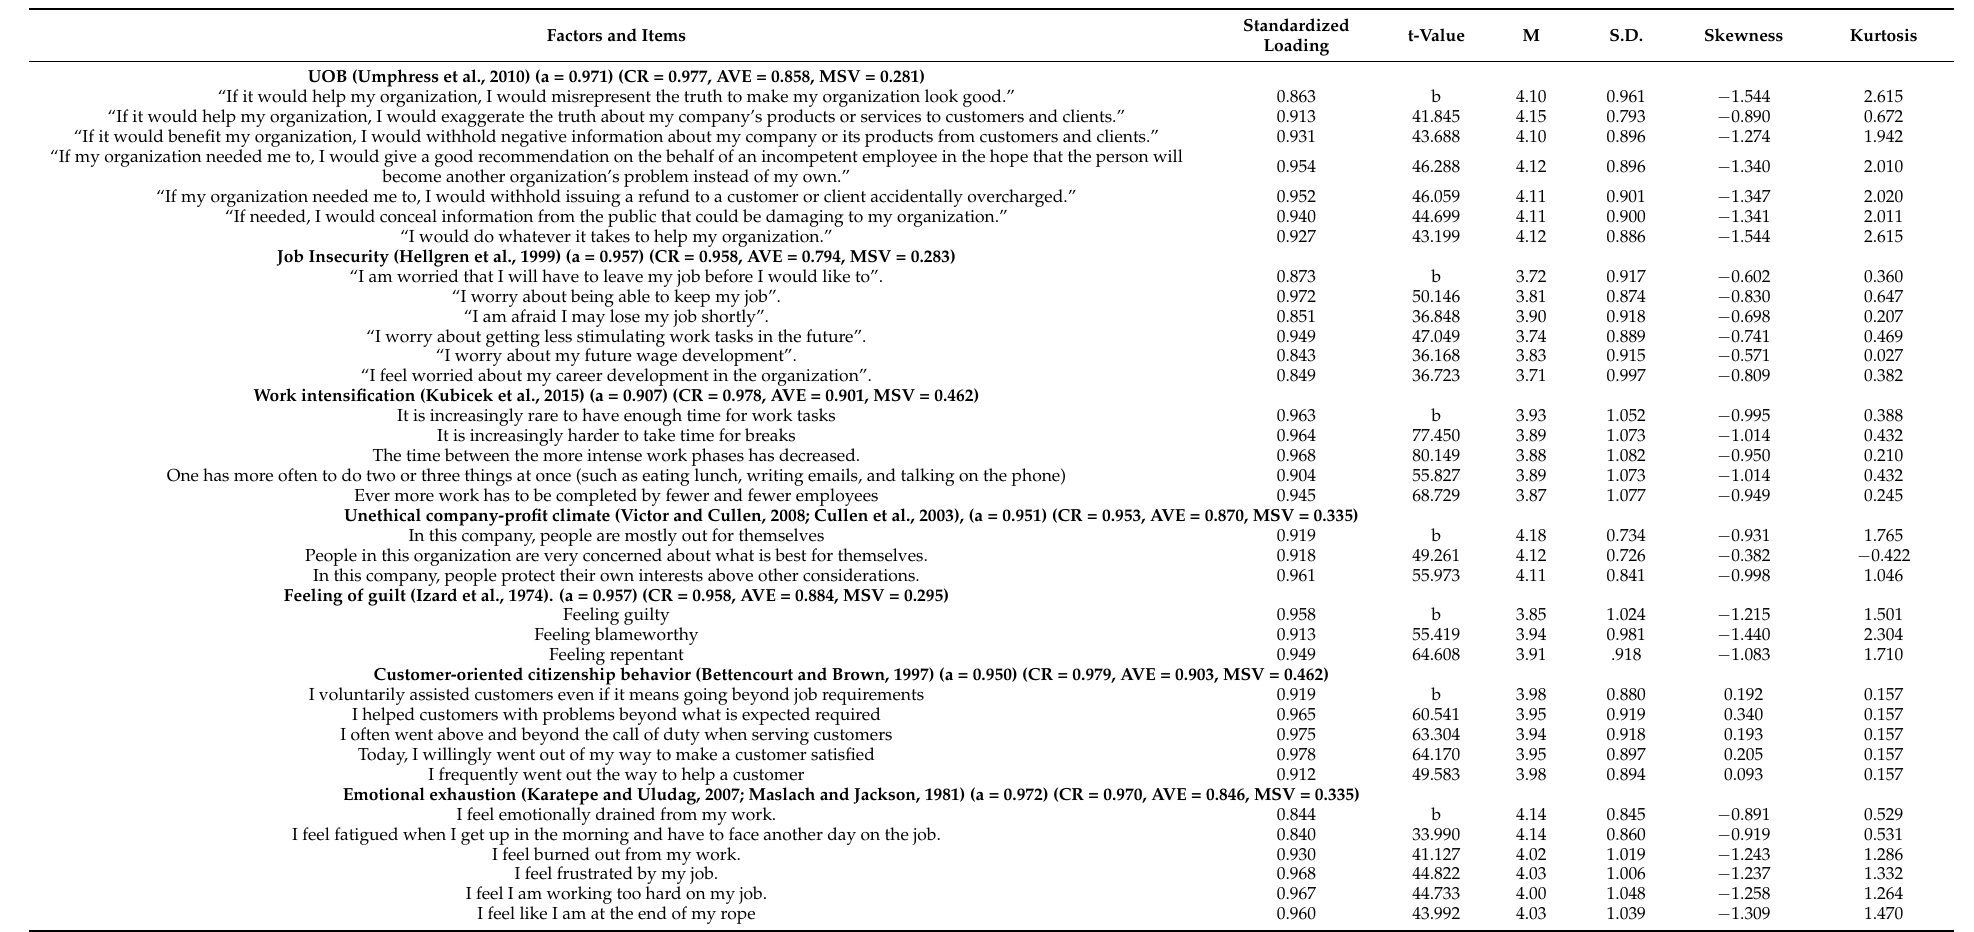
Table 2. Results of CFA— M and standard